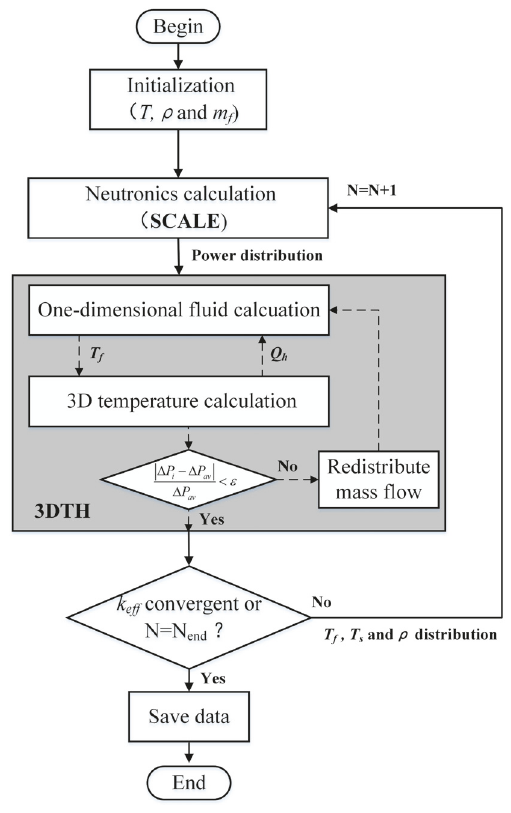
Figure 1: The flowchart of the coupled